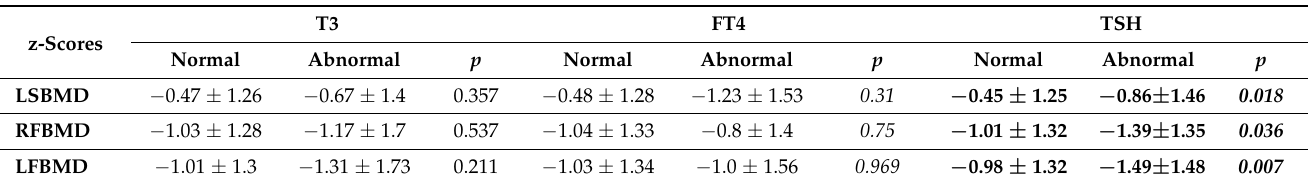
Table 2. The comparison of bone mineral density z-scores when triiodothyronine, free thyroxine, and thyrotropin levels were normal and abnormal.